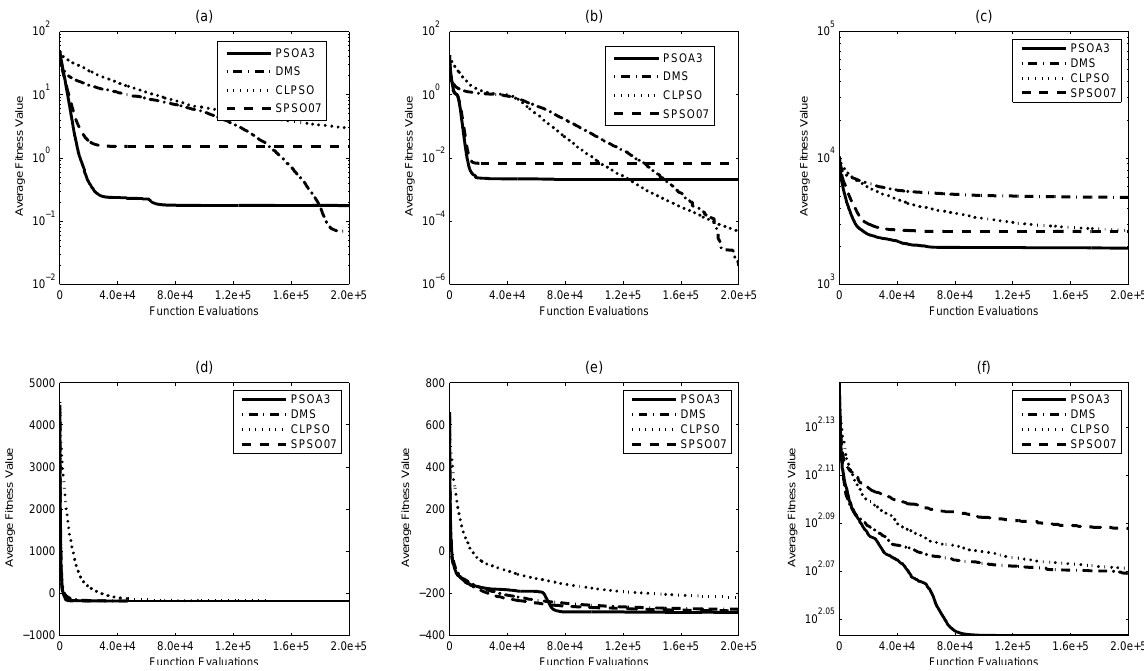
Figure 6: Average best fitness value for PSOA3, DMS-PSO,CLPSO and SPSO07 on the test functions.(a) f 10 . (b) f 11 . (c) f 12 . (d) f 13 . (e) f 14 . (d) f 15